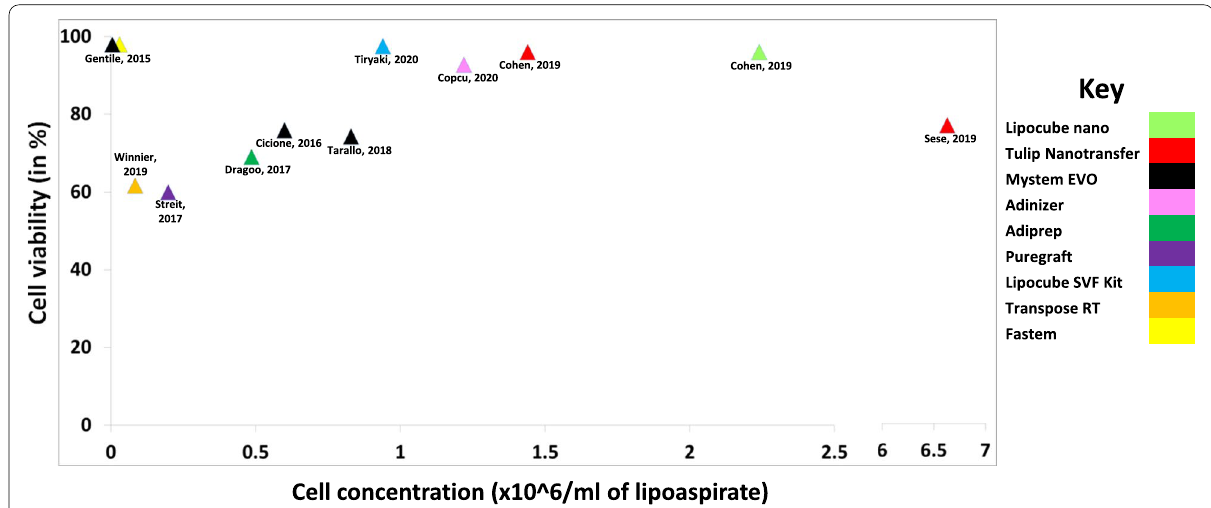
Fig. 4 Scatter graph of studies and their reported cell concentrations and viability (Studies without viability figures were